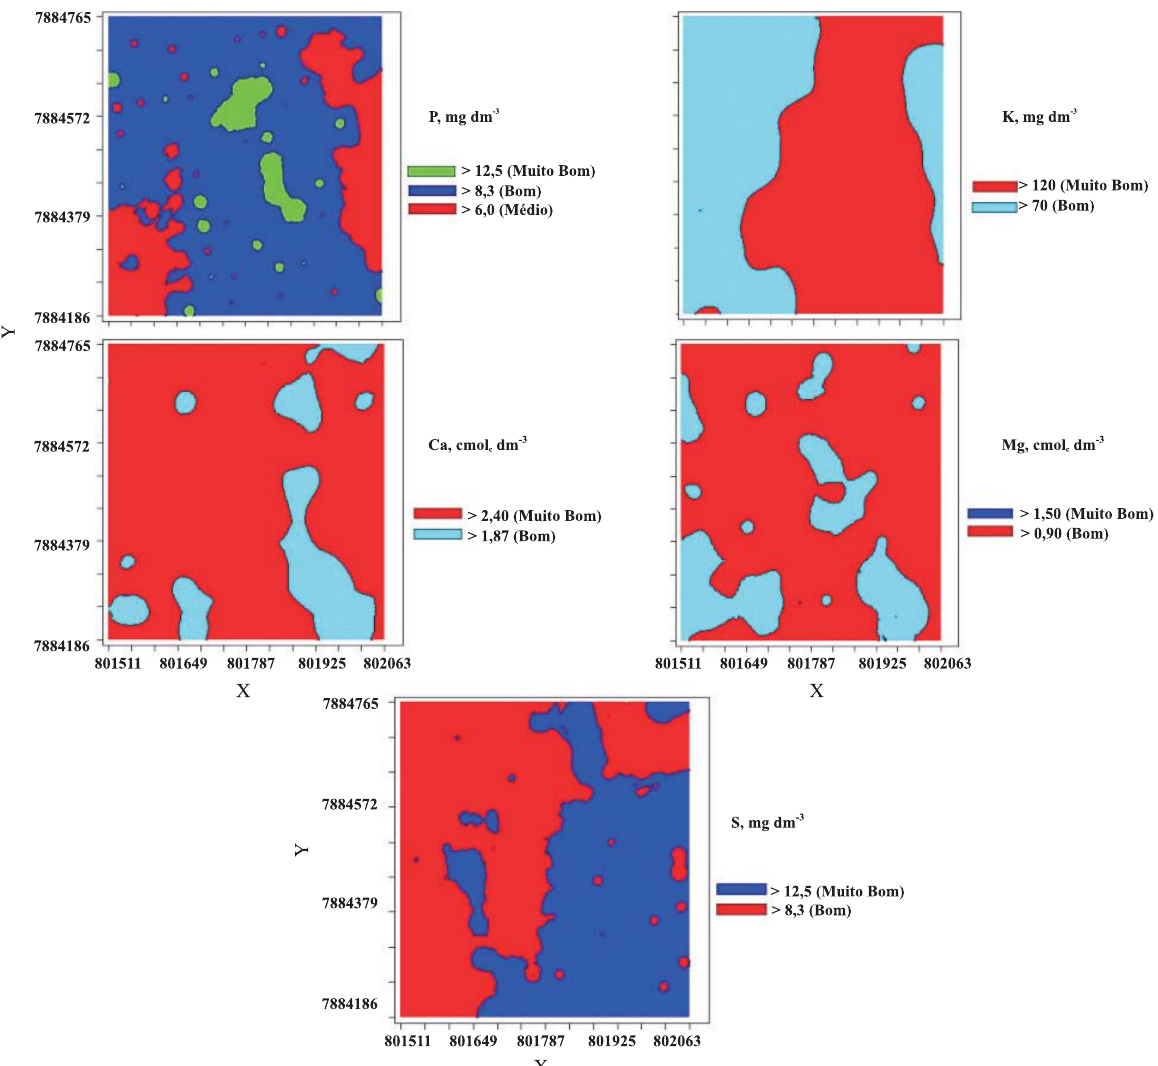
Figura 3. Mapas de isolinhas baseados nas classes de teores de macronutrientes (segundo Alvarez V. et al., 1999), na camada de 0–10 cm, em Latossolo Vemelho textura muito argilosa, sob sistema plantio direto (Fazenda Santa